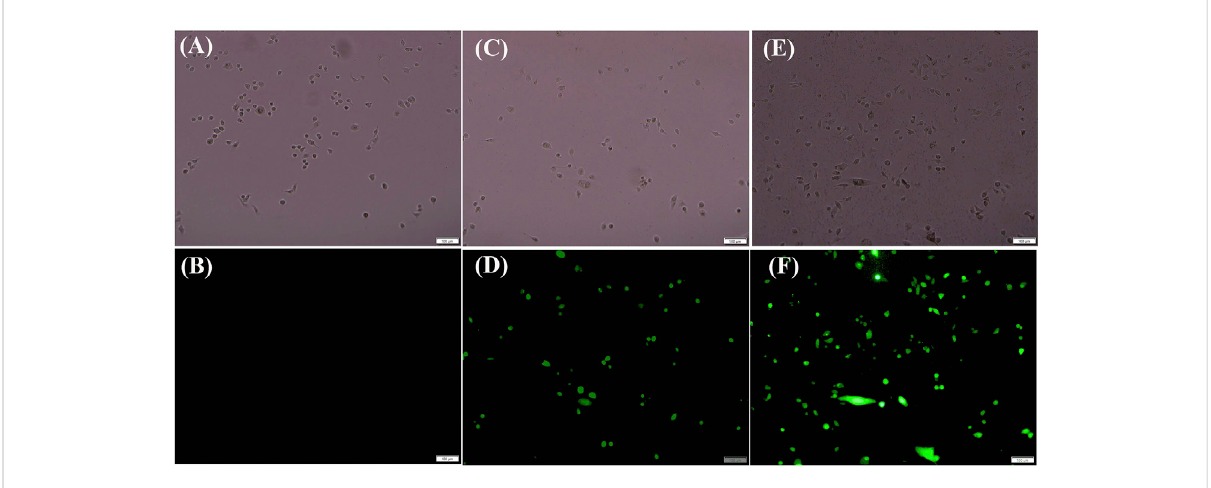
FIGURE 5 The production of ROS of Tumor Cells MDAMB231 treated with 5 visualized by fl uorescence microscope images of MDAMB231 cells. Control (A,B) , for 40 μ M (C,D) , 80 μ M (E,F) after treated with complex 5 for 24